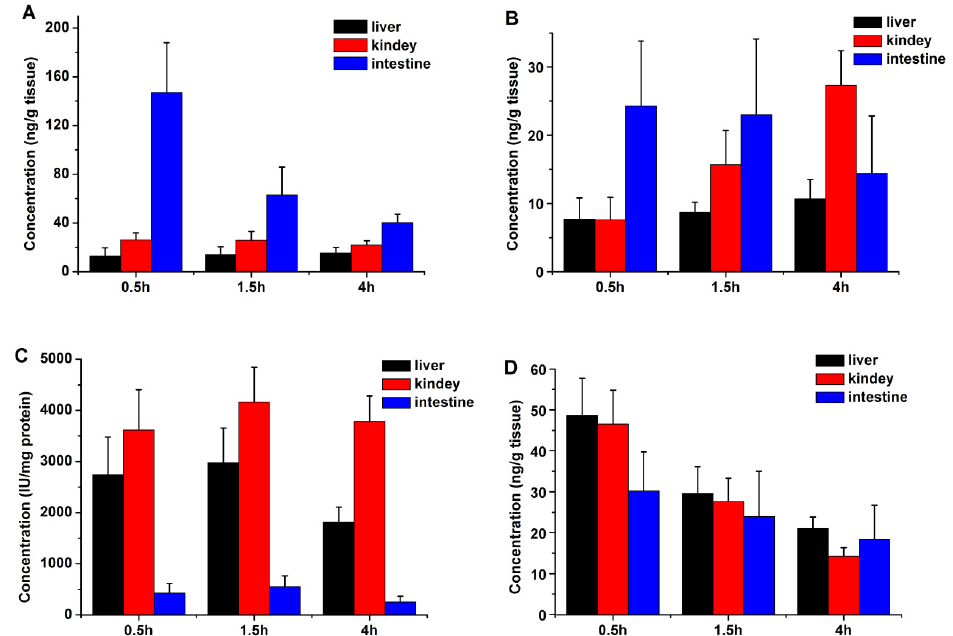
Figure 3. The tissue distributions of Cbz-dFdC and dFdC in rats. ( A ) Cbz-dFdC concentration